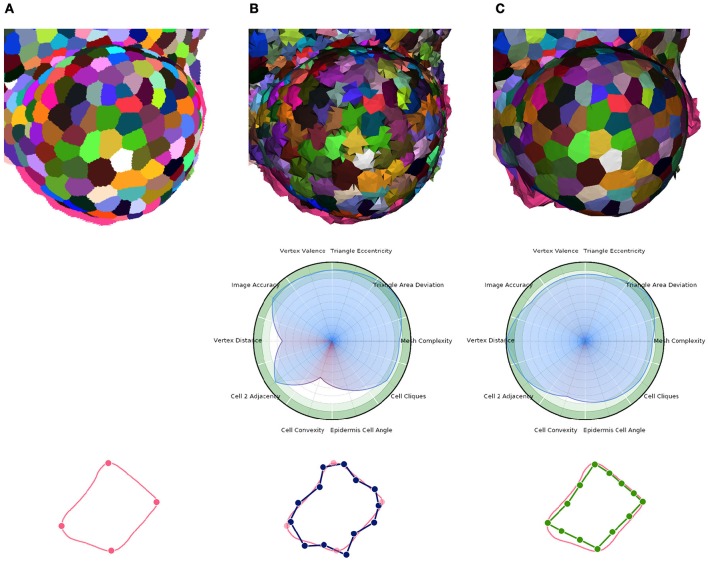
Multi-criteria quality estimation applied on two tissue meshes. Original segmented tissue image (A), coarse 3D triangular mesh obtained from interfaces of Delaunay refinement tetrahedra (IDRA) (B) and enhanced tissue triangular mesh optimized using the STEM algorithm (IDRA-STEM) (C), and a schematic representation of application of STEM on a cell interface contour.